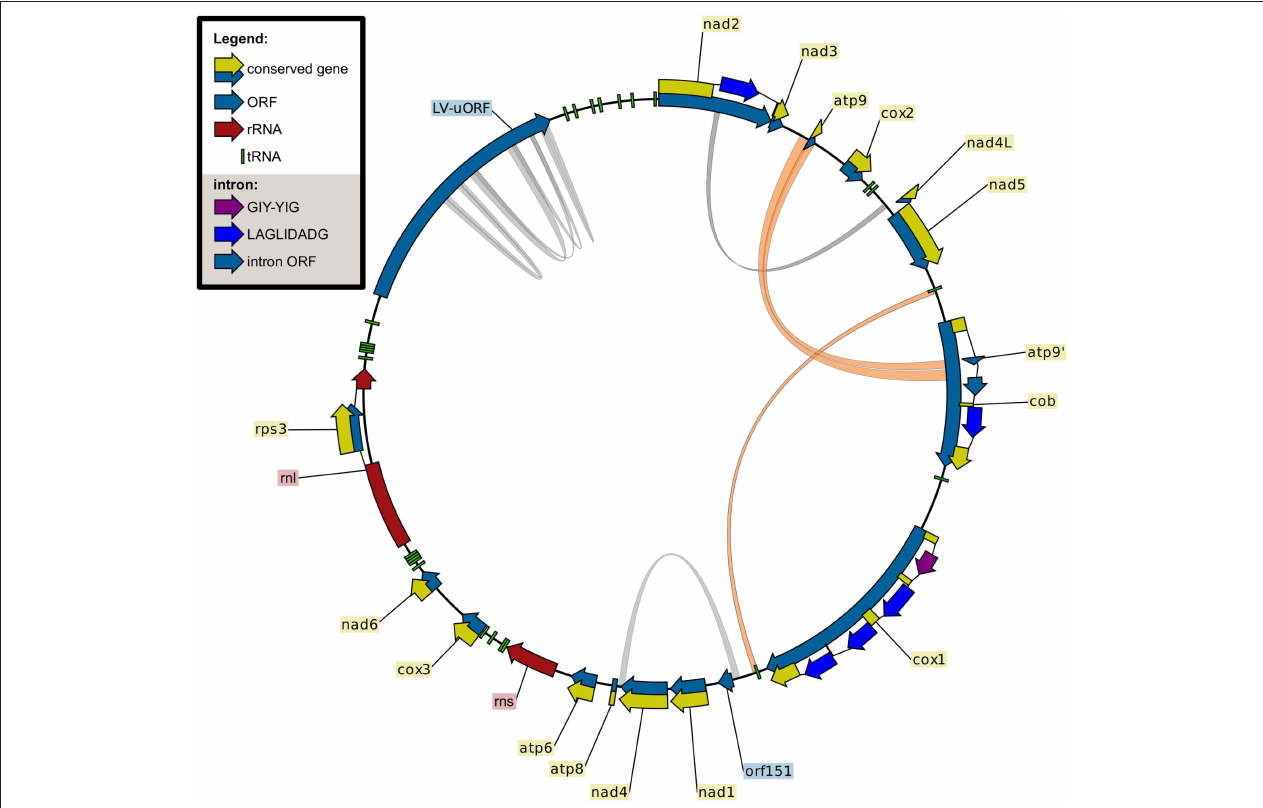
FIGURE 2 | Mitochondrial genome of Fusarium sacchari CBS 147.25. Genetic map created using CLC Sequence Viewer. Repeats larger than 100 bp were visualized using Circos, duplication of the atp9 region into cob-i393 and the two copies of trnR(tct) are shown in